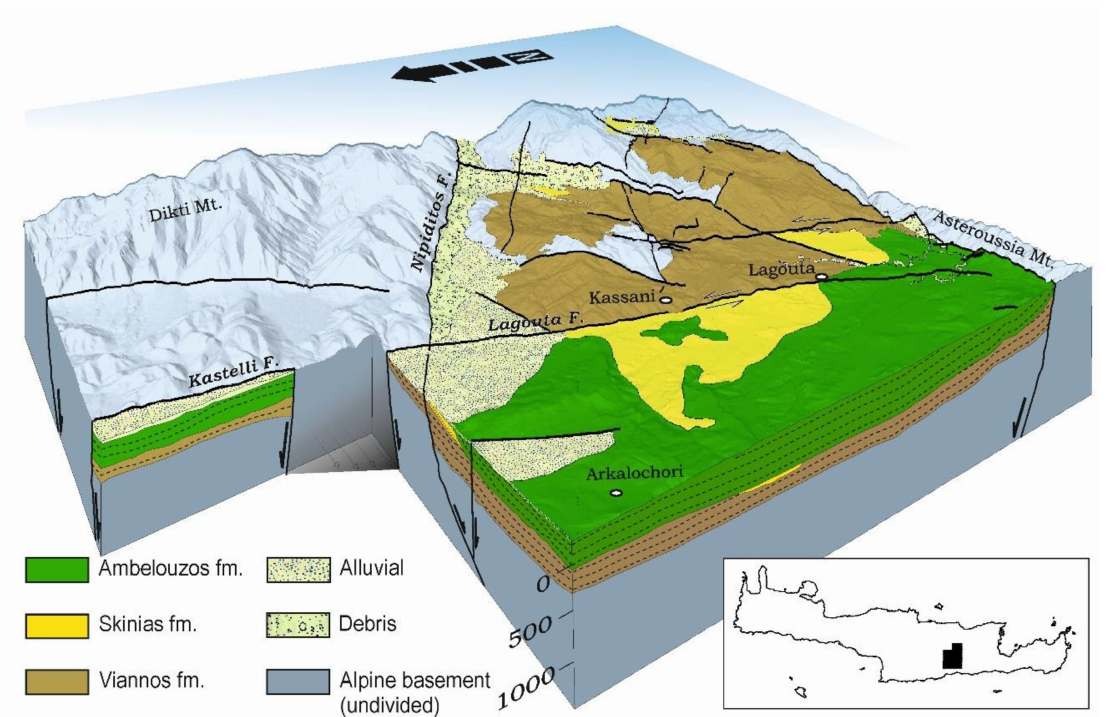
Figure 7. Simplified 3D block diagram of the eastern marginal area of MB. Arkalochori village is located at the hanging wall of Lagouta fault but also at the hanging wall of Nipiditos fault, which is segmenting the Kastelli fault